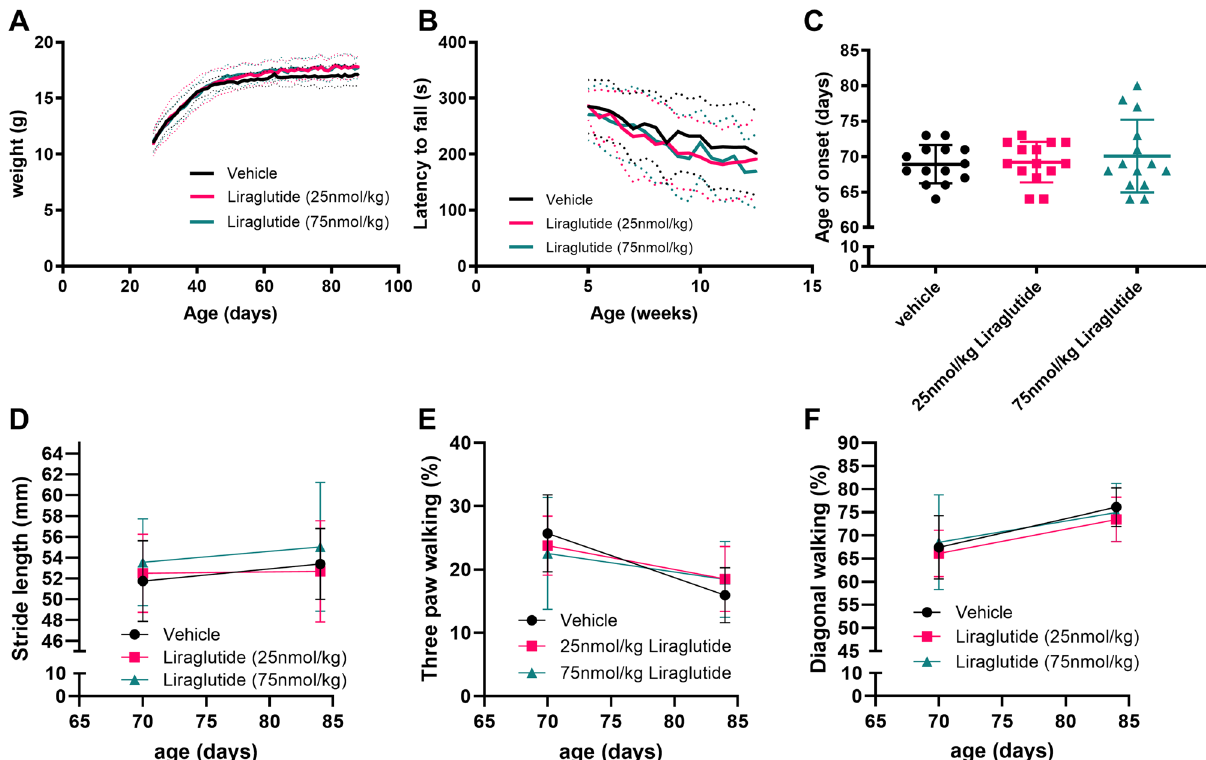
Figure 3. Liraglutide dosed once daily at 25 or 75 nmol/kg does not alter progression of disease in a SOD1 G93A mouse model of ALS. ( A ) Daily average body weight (mean ± SD) from 25 to 90 days of age of mice dosed with vehicle, 25 or 75 nmol/kg liraglutide once daily ip. Average shown as thick line and SD shown as thin dashed lines. No significant difference in body weight between liraglutide dosed and vehicle dosed animals (n = 14 per group, two-way ANOVA, P = 0.3165). ( B ) Rotarod data shown as latency to fall (mean ± SD) from 40 to 90 days of age. As expected, rotarod performance declined over time but there was no significant difference between vehicle and liraglutide dosed mice (n = 14 per group, two-way ANOVA, P = 0.5252). ( C ) Age of visible onset measured through twice weekly motor scoring shown as individual values with mean ± SD (n = 14 per group, one-way ANOVA, P = 0.7026). ( D ) Hindlimb stride length (mean ± SD) at 70 and 84 days of age showed no difference between liraglutide dosed and vehicle dosed animals (n = 8 per group, two-way ANOVA, P = 0.1298). ( E ) Percentage of time spent on diagonal paws (mean ± SD) at 70 and 84 days of age showed no difference between vehicle dosed and liraglutide dosed mice (n = 8 per group, two-way ANOVA, P = 0.7074). ( F ) Percentage of time spent on three paws (mean ± SD) at 70 and 84 days of age (n = 8 per group, two-way ANOVA, P =